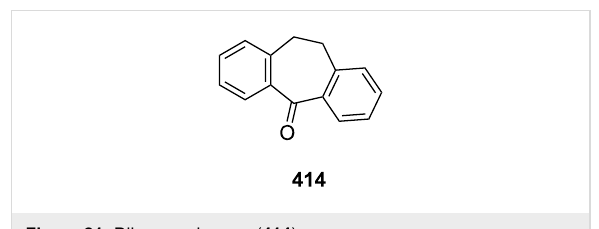
Figure 21: Dibenzosuberone ( 414 ).